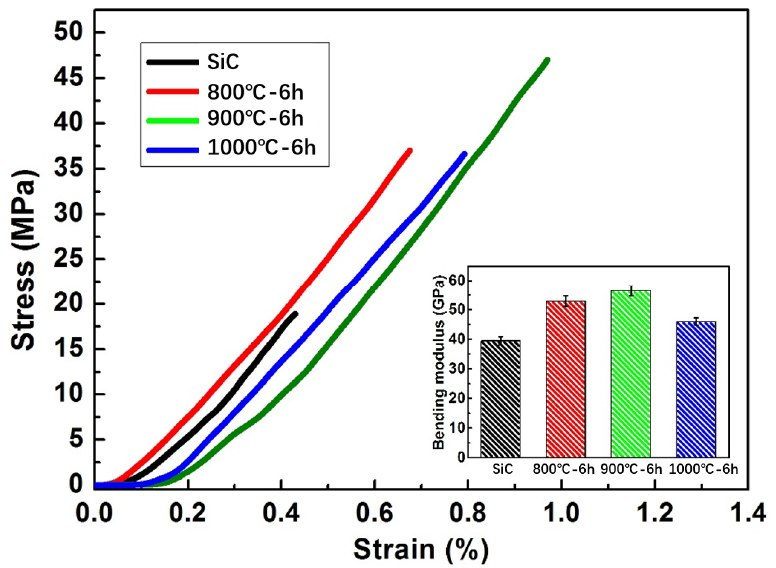
Figure 15. Bending strain-stress curves and bending modulus of SiC ceramics and SiC infiltrated at 800, 900, and 1000 °C for 6 h.